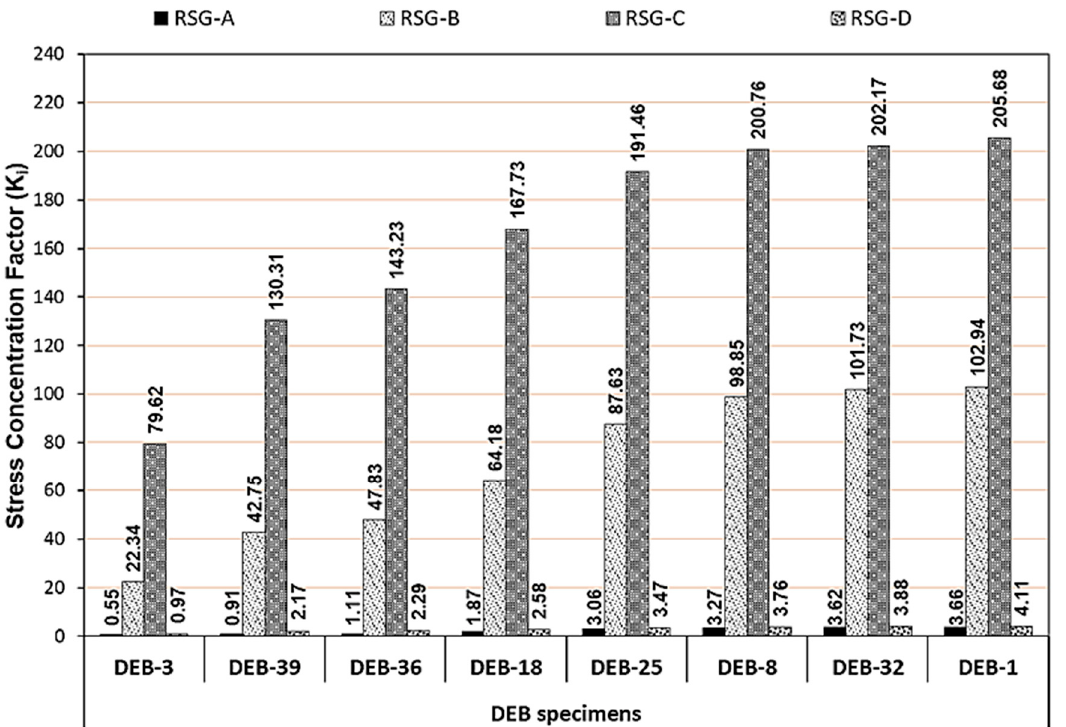
Figure 10. The SCF values of each DEB specimen are based on the RSG data. The fine cracks typically appeared in the un-dapped zone during the DEBs test. However, it did not occur in the region close to the nib corner. Furthermore, during the test, it was observed that the first crack always started at the re-entrant corner. Therefore, it can be seen that the re-entrant corner and its surroundings are constantly plagued with dominant cracks (including at the support). Thus, RC-DEBs’ damage and failure